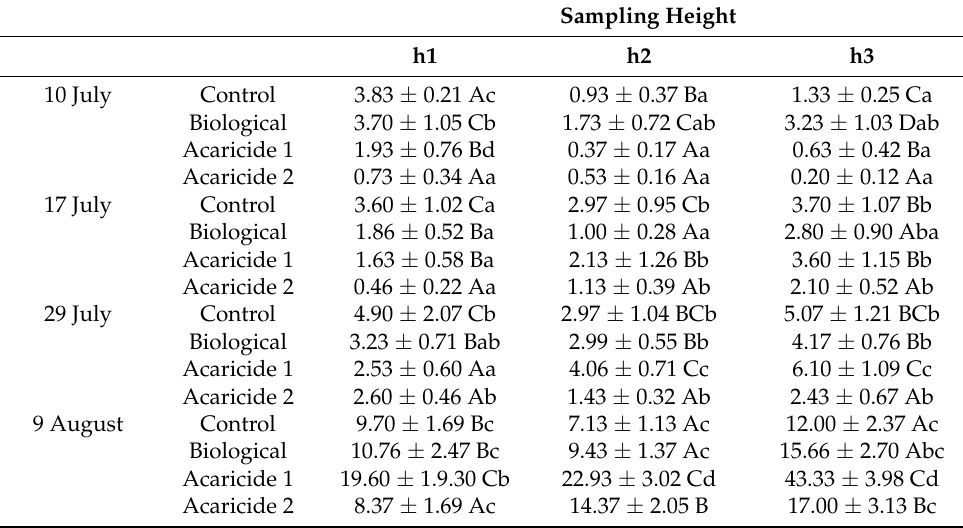
Table 5. Average number of two-spotted spider mite mobile stages per leaf according to different sampling heights.